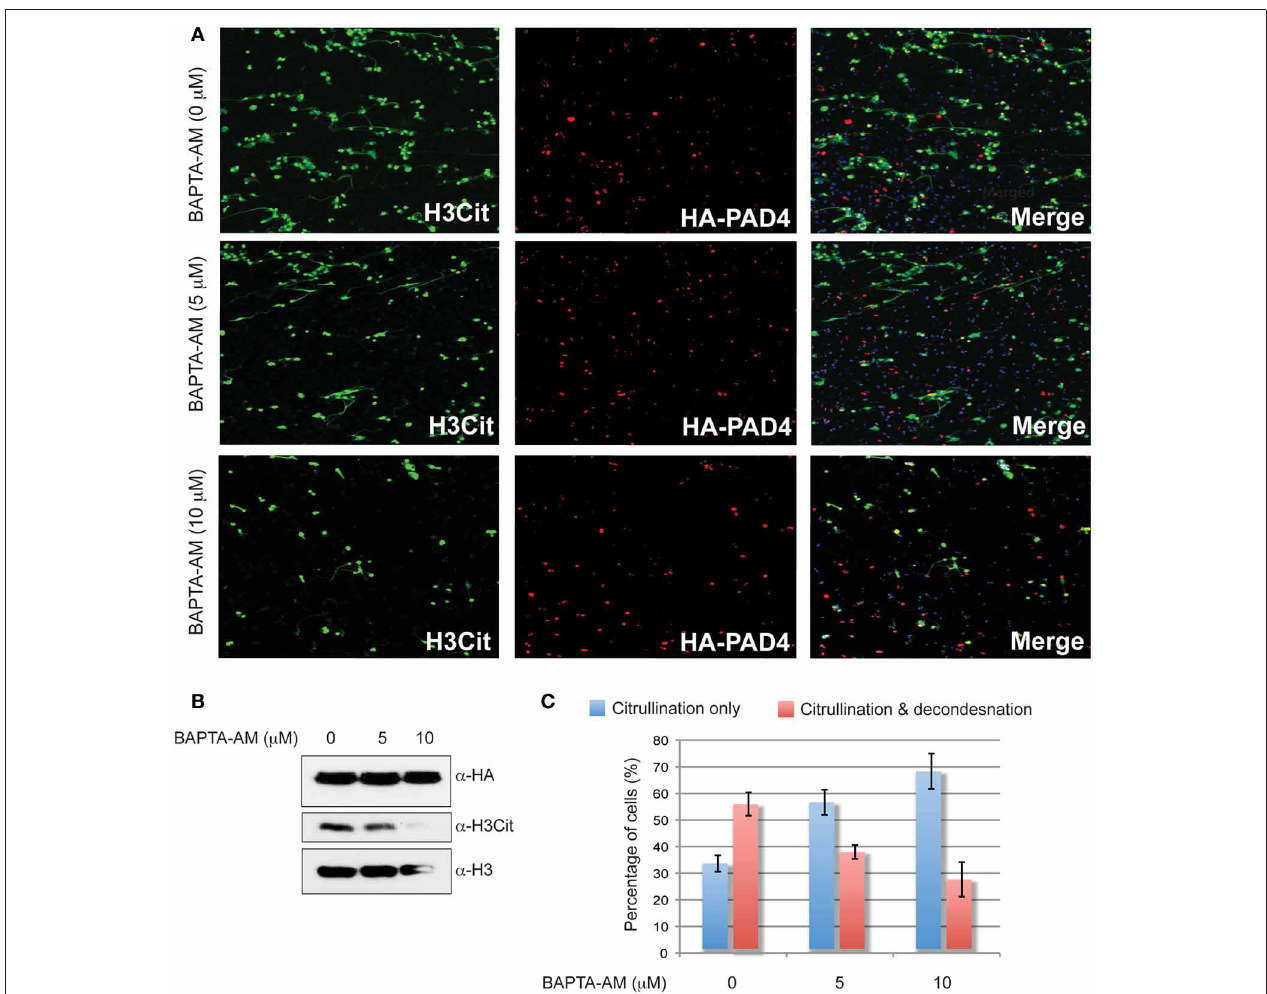
FIGURE 4 | The calcium chelator BAPTA-AM attenuates histone hypercitrullination and chromatin decondensation induced by forced HA-PAD4 expression. (A) Fluorescent microscope analyses of histone H3Cit levels in U2OS cells transfected with the pSG5-HA-PAD4 plasmid and then treated with BAPTA-AM at 0, 5, and 10 μ M concentrations. (B) Western blot analyses of histone H3Cit levels in U2OS cells transfected with the pSG5-HA-PAD4 plasmid then treated with BAPTA-AM. Histone H3 blot was